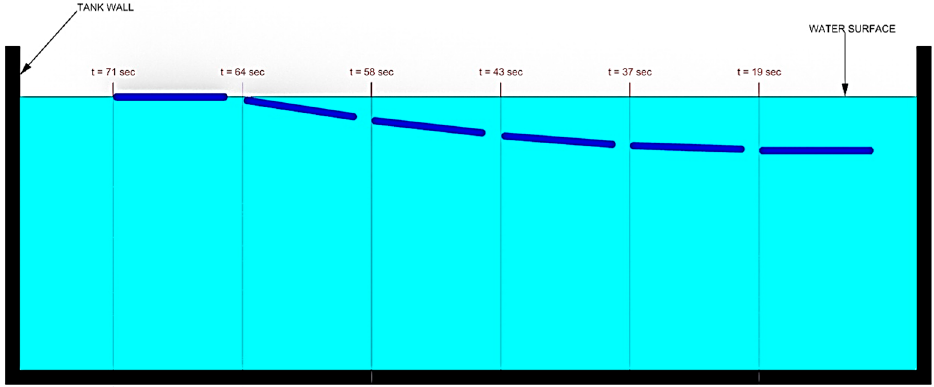
Figure 15. Time lapse of NEELBOT 1.2 swimming while changing depth in the towing tank.